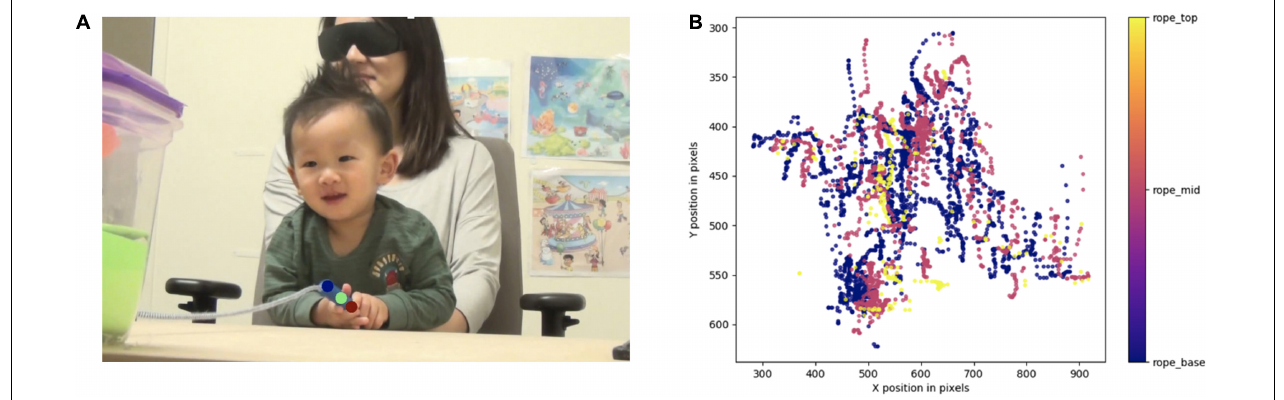
FIGURE 1 | (A) A still from a participant video showing markers generated by DLC after training the neural network. The three parts of the rope labeled and tracked were: the base of the rope handle (blue), the middle of the rope handle (green), and the end of the rope handle (red). (B) A graphical representation of the coordinates extracted from DLC. Additionally, we have uploaded a video of one of this participant’s test trials with computed marker overlay. Video playback is in real time and can be found here: